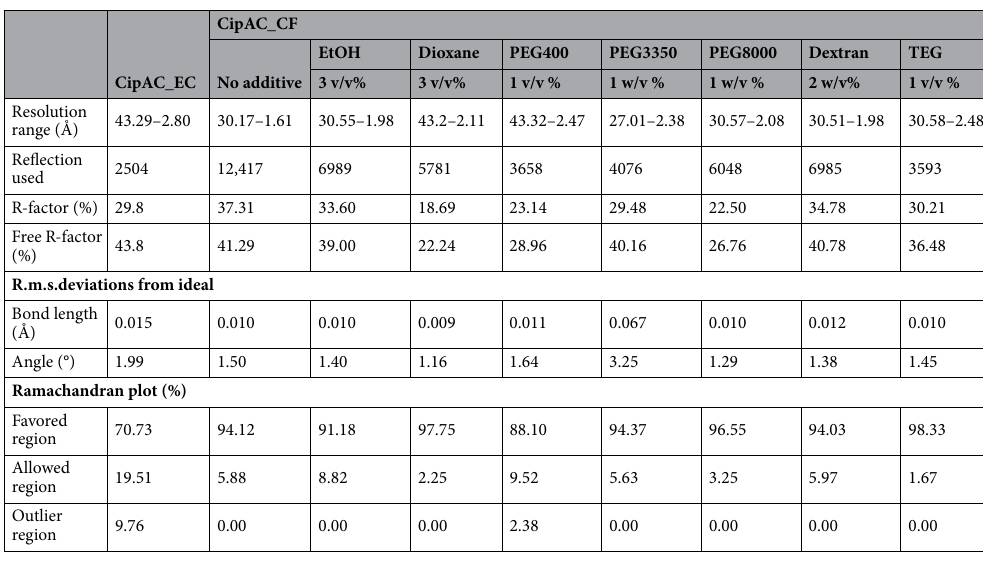
Table 5. Refinement statics of CipAC_EC and CipAC_CF .